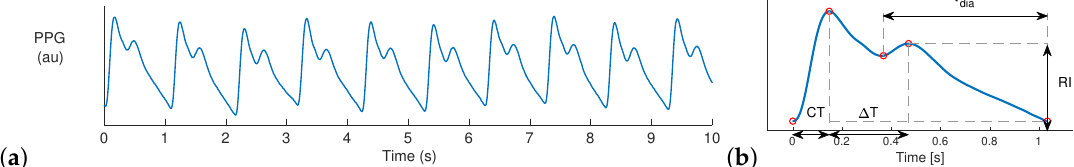
Figure 1. The photoplethysmogram (PPG) signal: ( a ) A 10-s recording, exhibiting a pulse wave for each heart beat—approximately one per second; ( b ) Extracting four exemplary vascular recovery rate (VRR) indices from a pulse wave (defined in Abbreviations section at end). au: arbitrary